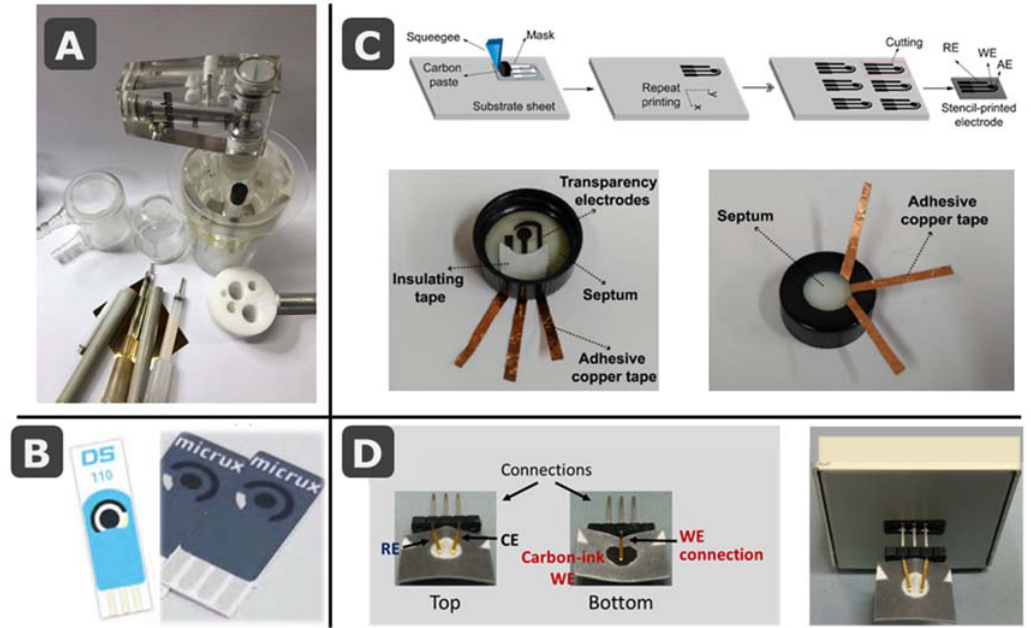
Figure 1. ( A ) Picture of conventional electrochemical cells with pen-like electrodes. ( B ) Examples of commercial screen-printed electrode cards from DropSens (ceramic substrate [13]) and MicruX (polymeric substrate [14]). ( C ) Schematic drawing of the stencil ‐ printing process to fabricate several low ‐ cost electrodes on a transparency sheet, with pictures showing the integration of the transparency electrode onto the cap of a sample vial for on ‐ site water analysis. ( D ) Pictures of a paper ‐ based electrochemical cell containing the three electrodes (top and bottom views), also inserted in a commercial interface that connects electrodes to the potentiostat. ( C ) and ( D ) are reprinted from [15] (Chapters 4 and 25), Copyright (2020), with permission from Elsevier.